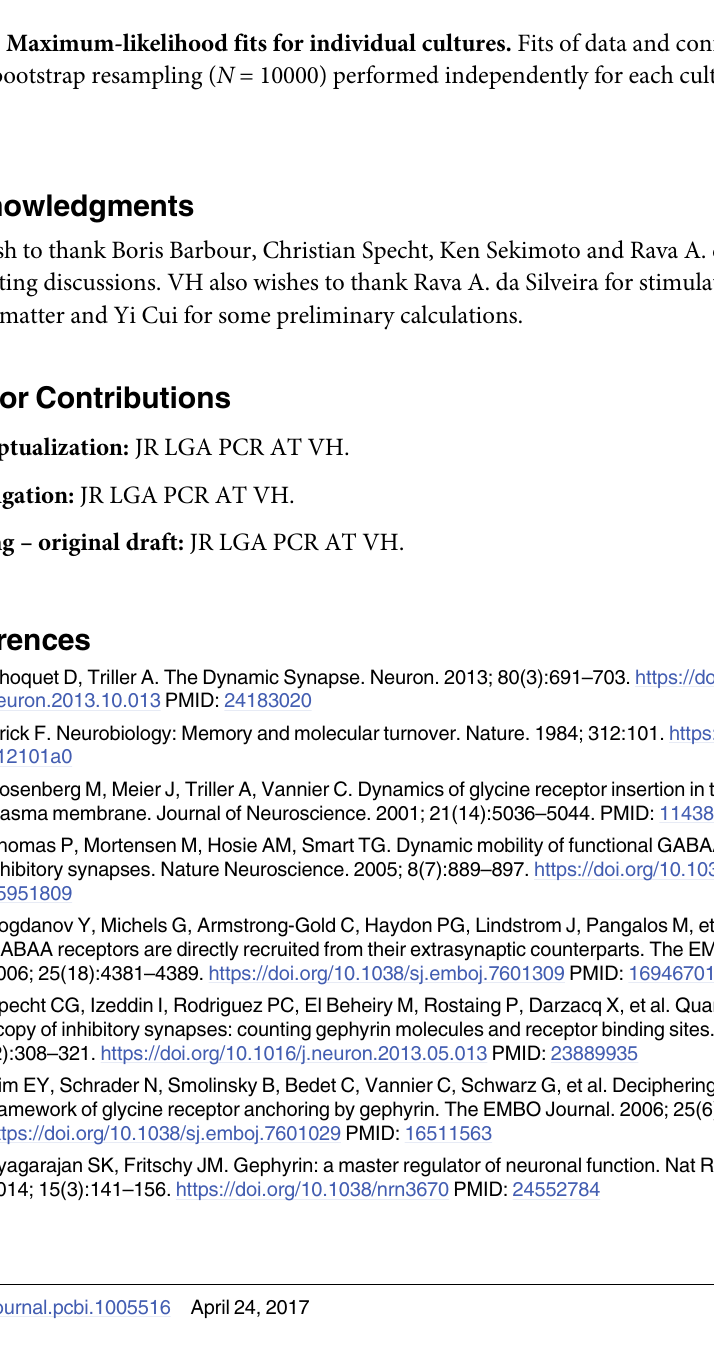
S1 Fig. Rate-equation description of scaffold-cluster aggregation. Comparison and match of the cluster size distributions obtained from the rate-equation description to the full simula- tions. S2 Fig. Fluorophore detections per cluster. Raw data of the fluorophore detections from which the gephyrin cluster sizes were obtained. S3 Fig. Maximum-likelihood fits for individual cultures. Fits of data and confidence regions using bootstrap resampling ( N = 10000) performed independently for each